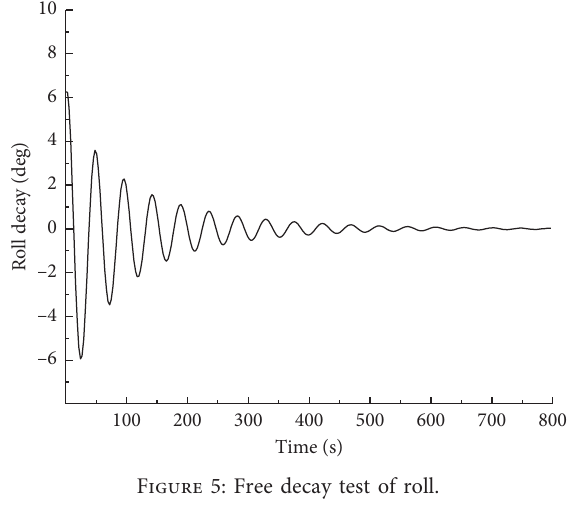
Figure 5: Free decay test of roll.